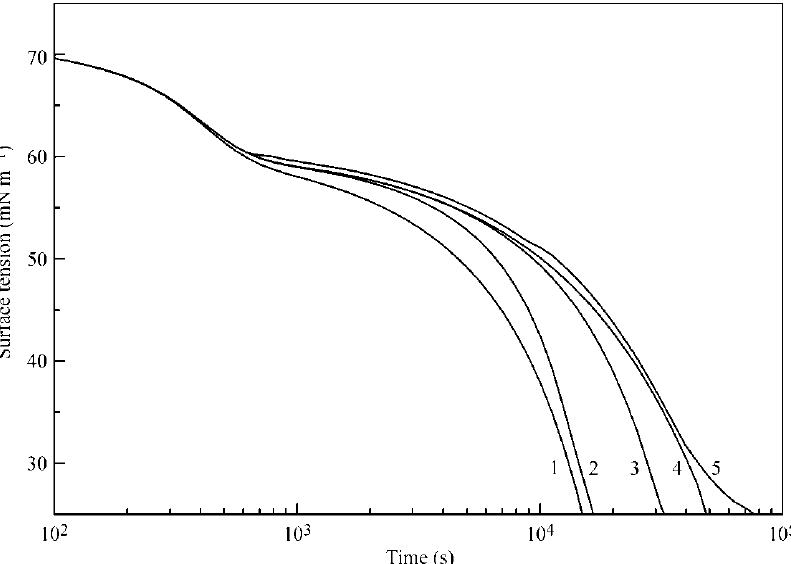
Figure 6. Influence of certain model parameters on the dynamic surface tension. For detailed discussion, see text.